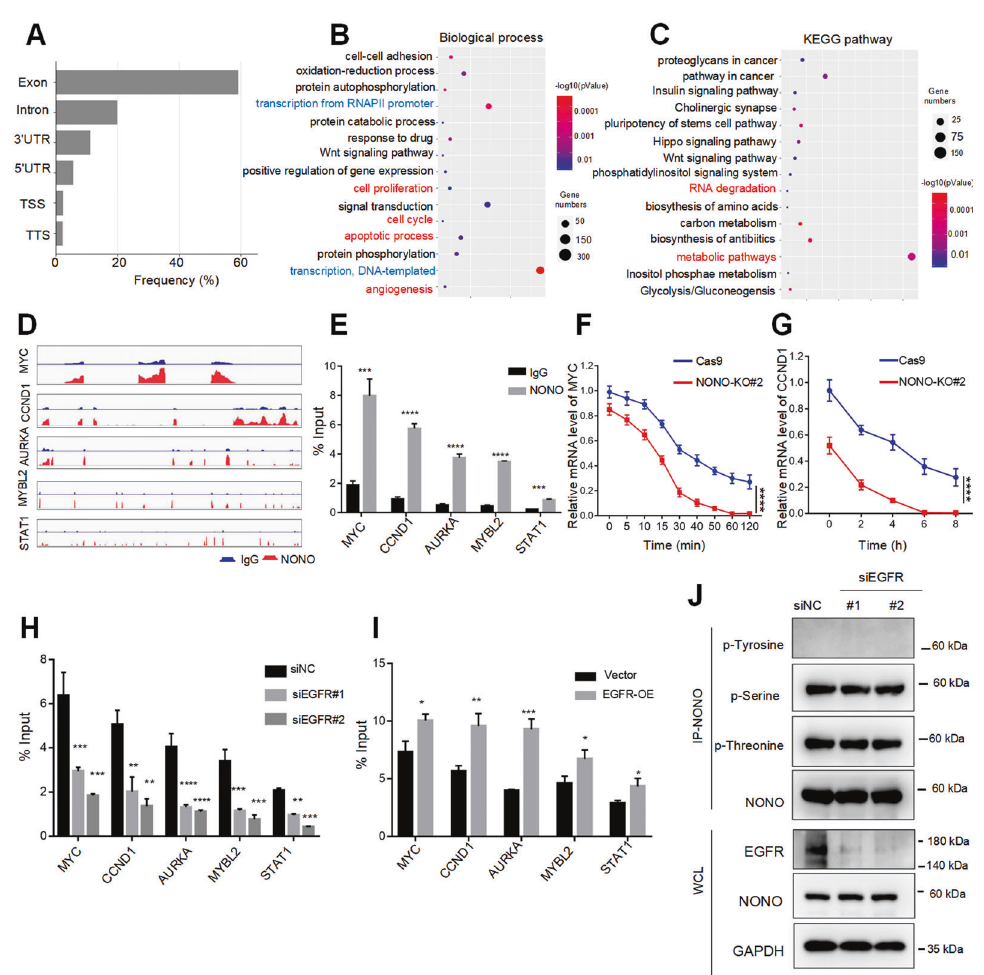
Fig. 6 Nuclear EGFR regulates the af fi nity of NONO to mRNAs. A Distribution of NONO RIP-sequencing peak annotation for different regions. B , C Gene enrichment of biological process ( B ) and enriched KEGG pathways ( C ) analysis for the NONO-bound mRNA. D IGV software view of the RIP-seq reads mapping to MYC, CCND1, AURKA, MYBL2, STAT1 gene. E Lysate from MDA-MB-468 was subjected to RIP assay, then RIP assay products were extracted by Trizol and quanti fi ed by RT-qPCR with indicated pairs of primers. F , G MD-MB-231 cells were treated with actinomycin D (2 μ M) and harvested at the indicated time points, then RNA was extracted from these cells and quanti fi ed by RT-qPCR with the indicated pairs of primers. H , I The effect of EGFR on the RNA-binding af fi nity of NONO was identi fi ed by knockdown ( H ) or overexpressing EGFR ( I ) in MDA-MB-231 cells. J The effect of EGFR knockdown on the phosphorylation of NONO in MDA-MB-231 cells. The displayed values are the mean ±standard deviation. The triplicate measurement results were repeated 3 times and the results were similar. * P <0.05; ** P <0.01; *** P < 0.01 versus the corresponding control. Cell Death and Disease (2022)